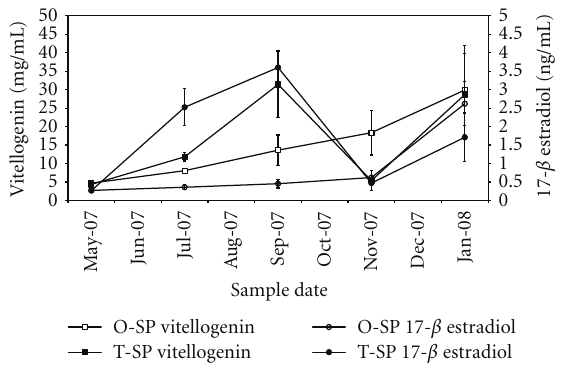
Figure 5: Sex steroid profiles in rainbow trout during the reproduc- tive cycle. O-SP: once spawners; T-SP: twice spawners (Mean ± SE, n = 4).